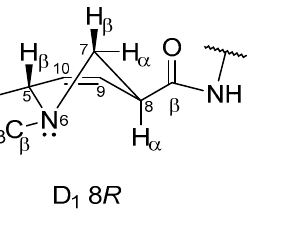
Figure 3. Possible conformations of ergoline D-ring in solution.